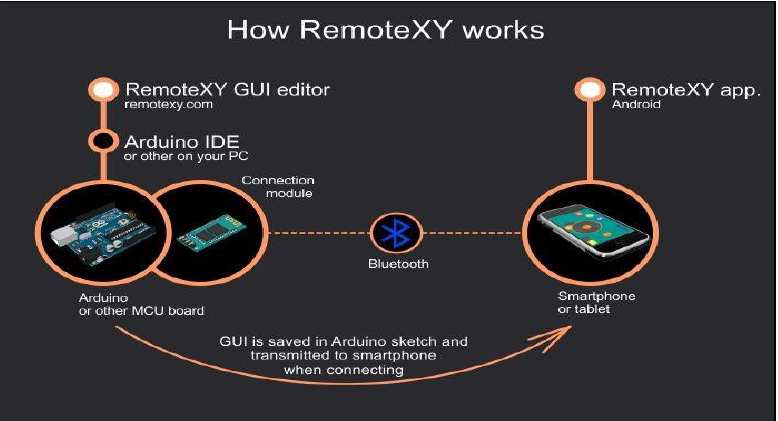
Figure 2. The work of RemoteXY in creating the graphical user interface.